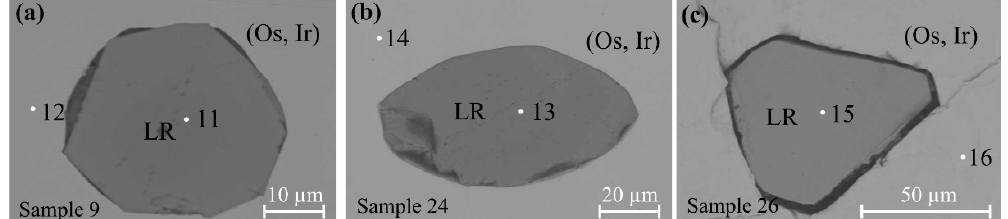
Figure 6. Back-scattered images of laurite grains of type 2 at Verkh-Neivinsk: ( a )—sample 9, ( b )—sample 24, ( c )—sample 26. LR—laurite, (Os,Ir)—iridian osmium. Numbers 11–16 denote areas of electron microprobe analyses corresponding to the same numbers in Table 2. Table 1. Electron microprobe analyses of Ru-Os sulfides of type 1 from the Verkh-Neivinsk massif.